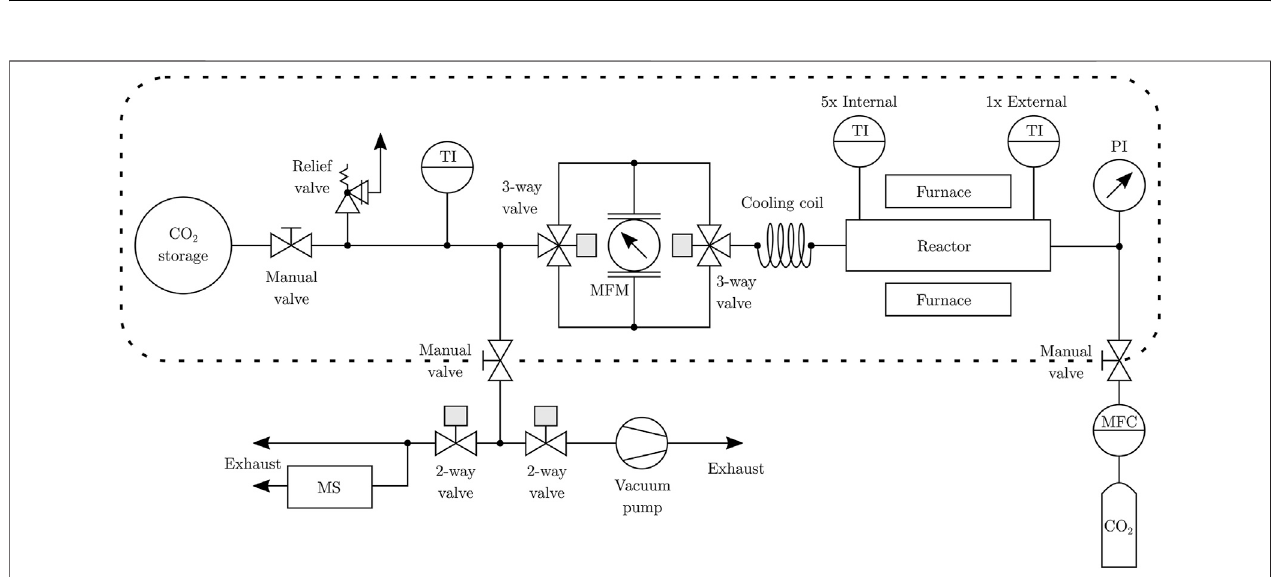
FIGURE 6 | Piping and instrumentation diagram of the experimental setup. The dashed box indicates the system con fi guration during normal operation.